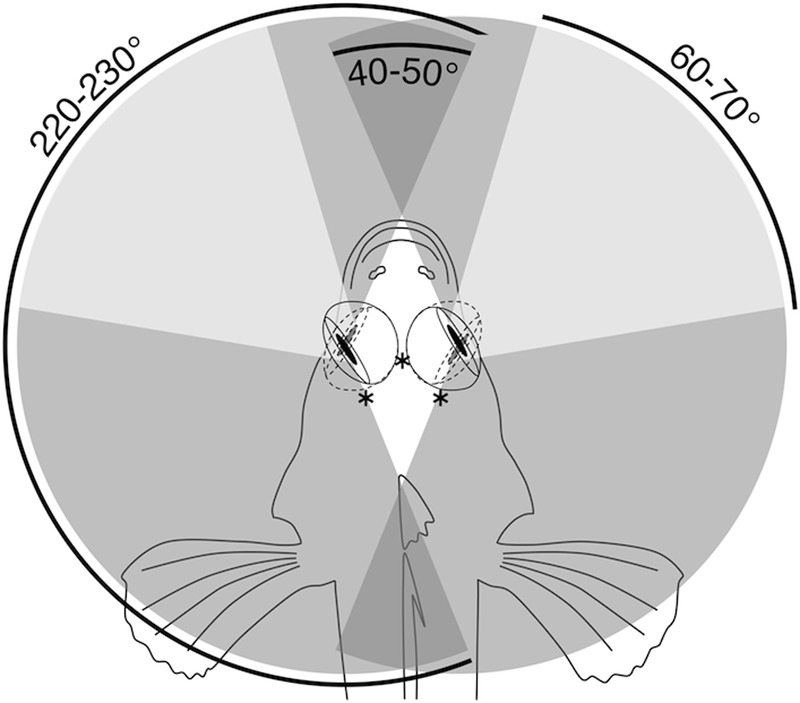
Horizontal visual field in T. delaisi. Schematic top view of T. delaisi’s head showing the extreme frontal and temporal orientation of its eyes (solid and dashed lines) and the associated foveal positions (∗). The shaded areas indicate the resulting maximum total (medium gray), binocular (dark gray), and foveate (light gray) horizontal fields of view based on the extent of eye movement.